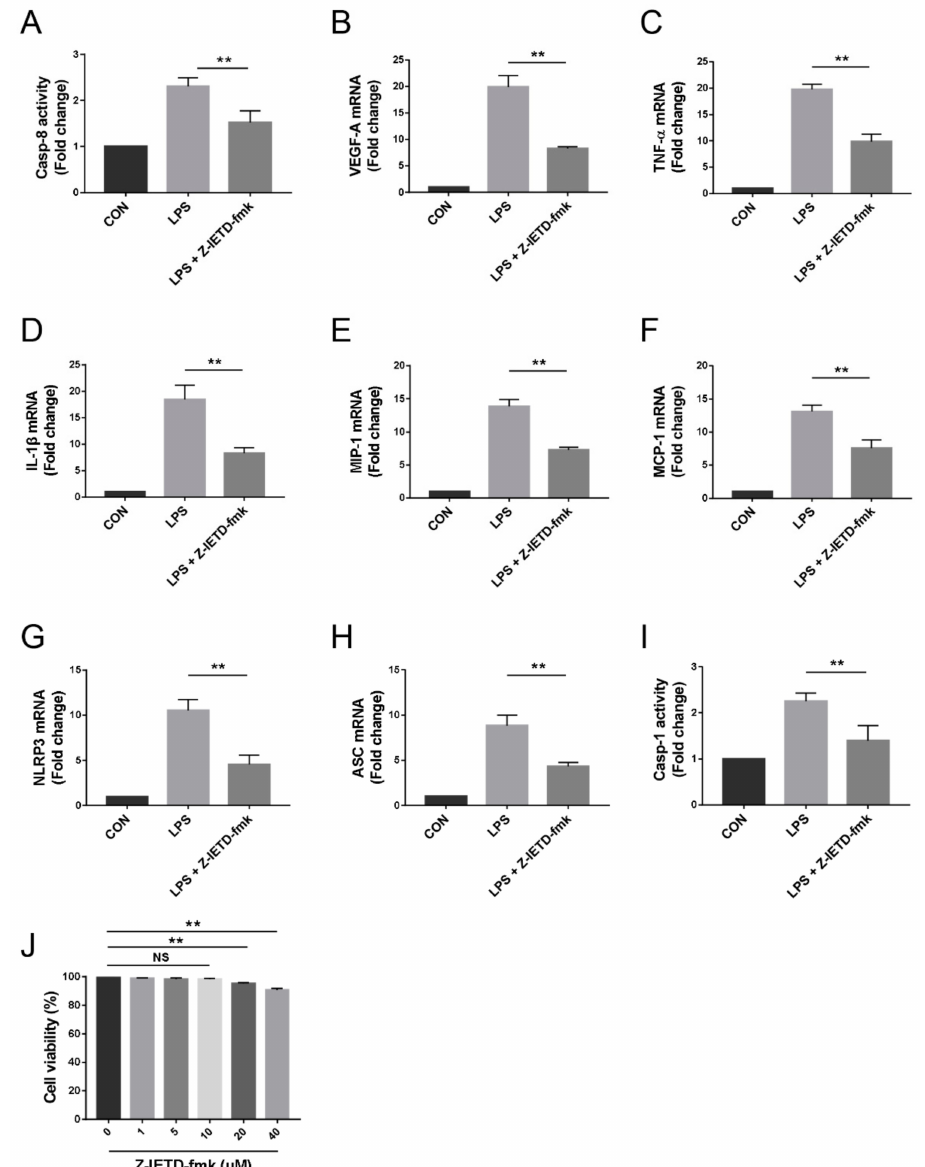
Figure 6. Pharmacological inhibition of caspase-8 suppressed the inflammatory profiles of RAW264.7 cells. ( A ) Colorimetric assay of caspase-8 activity in RAW264.7 cells ( n = 3). ( B – H ) RT-qPCR analysis of VEGF-A, TNF- α , IL-1 β , MIP-1, MCP-1, NLRP3, and ASC mRNA expression in RAW264.7 cells ( n = 3). (I) Colorimetric assay of caspase-1 activity in RAW264.7 cells ( n = 3). ( J ) Trypan blue exclusion assay for cell viability ( n = 3). The data are presented as the mean ± SD. NS p > 0.05, ** p <